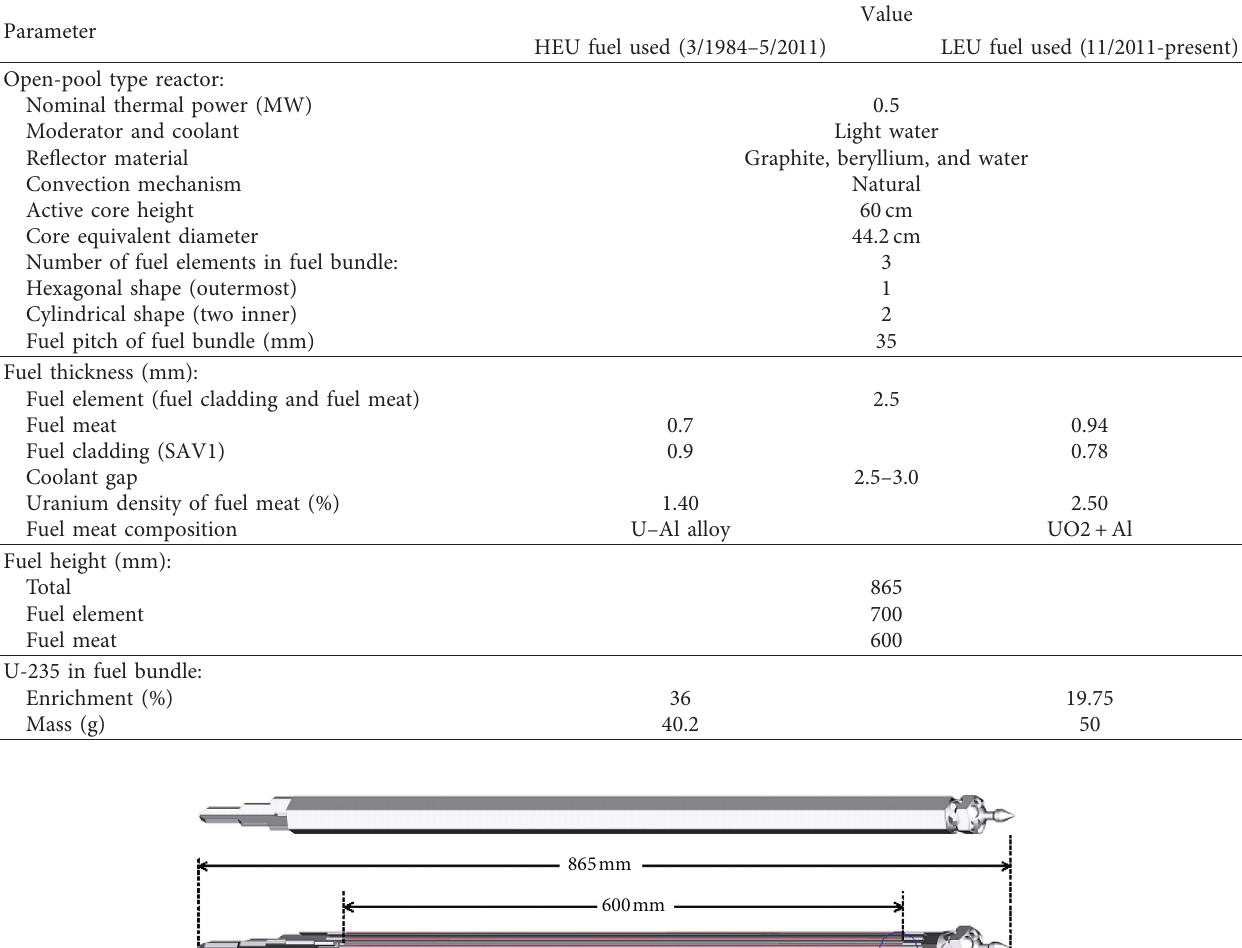
Table 1: Characteristics of the DNRR and its HEU and LEU VVR-M2 fuel types.